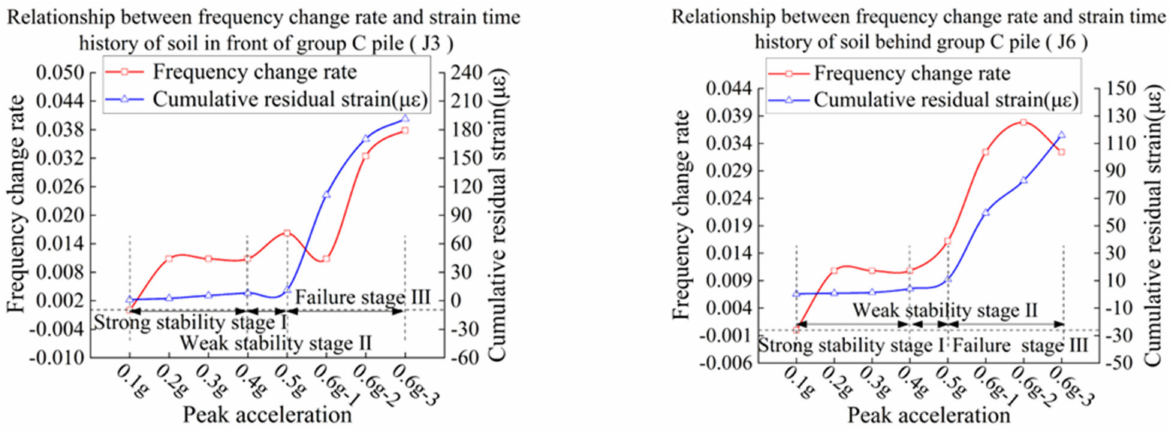
Figure 24. Slope cumulative strain-frequency decline rate curve of model